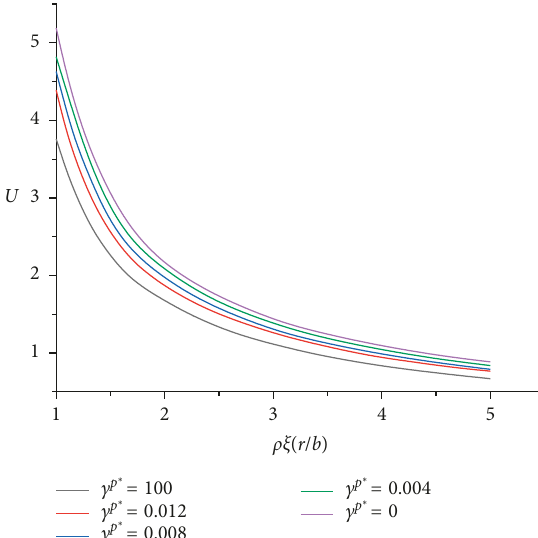
Figure 15: Distribution of radial displacement for different values of a